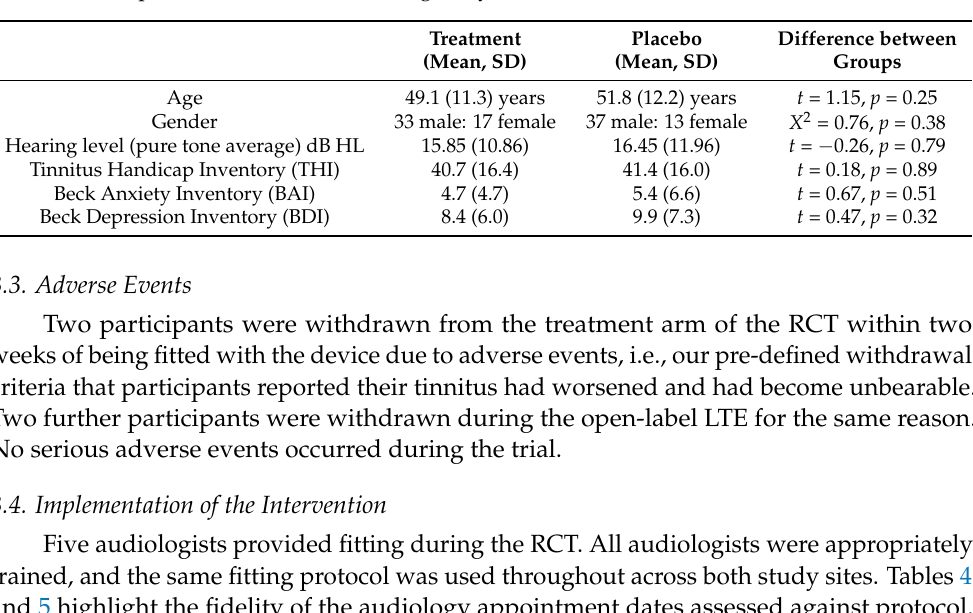
Table 3. Participant characteristics at the eligibility assessment (visit 1). SD = standard deviation.